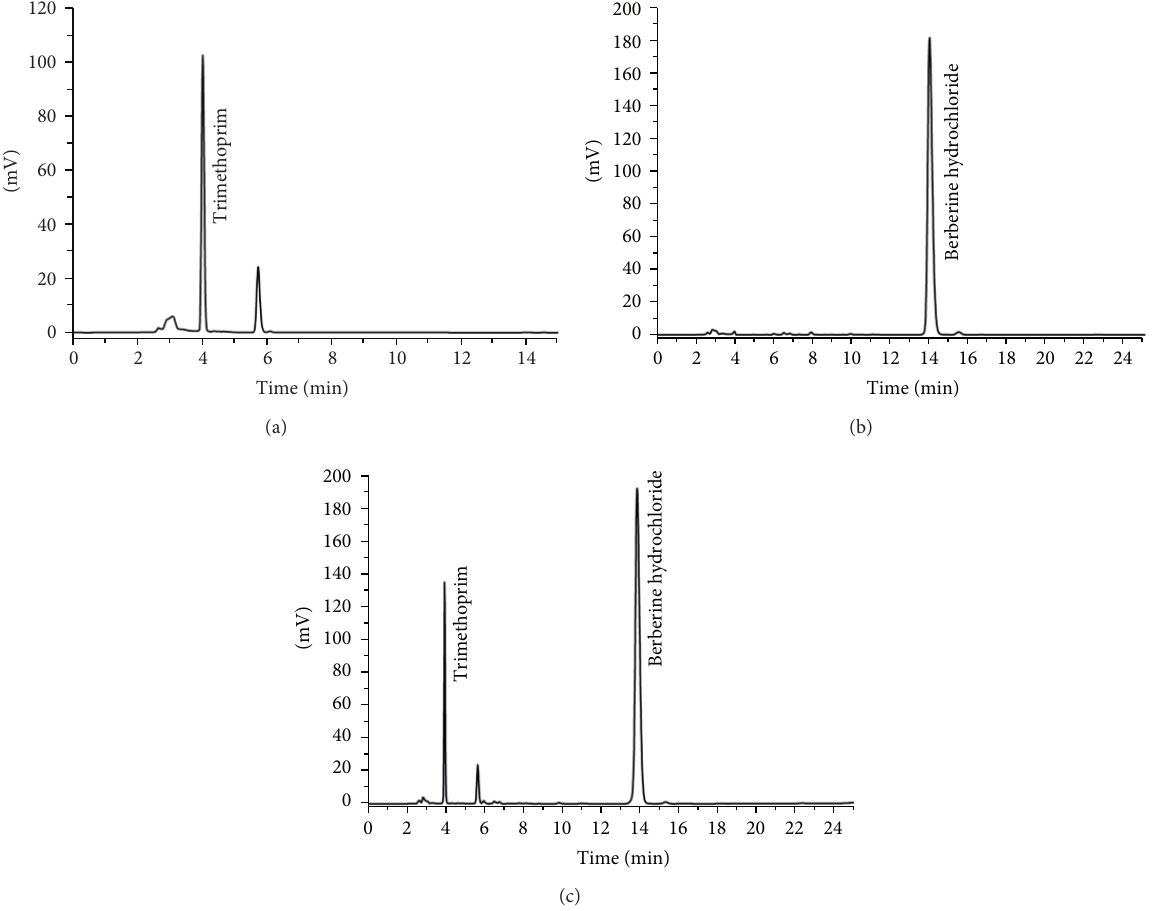
F 2: Typical HPLC chromatograms of acid hydrolysis degraded (a) trimethoprim, (b) berberine hydrochloride, and (c) combined capsule